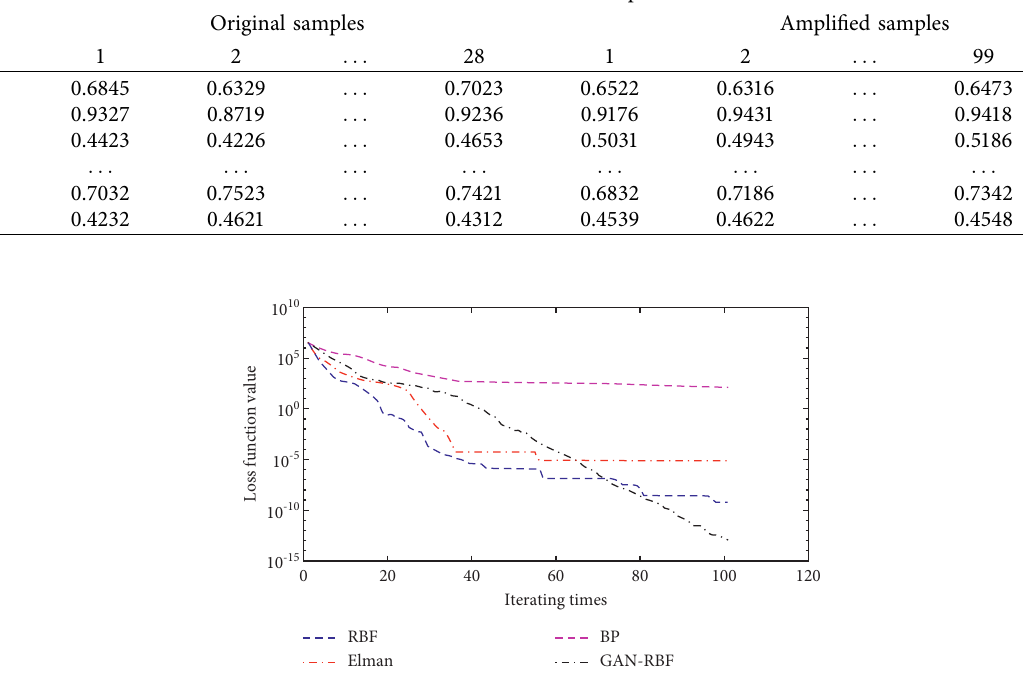
Figure 4: Comparison of four models’ iteration curve. E5E4E3E2E10.96